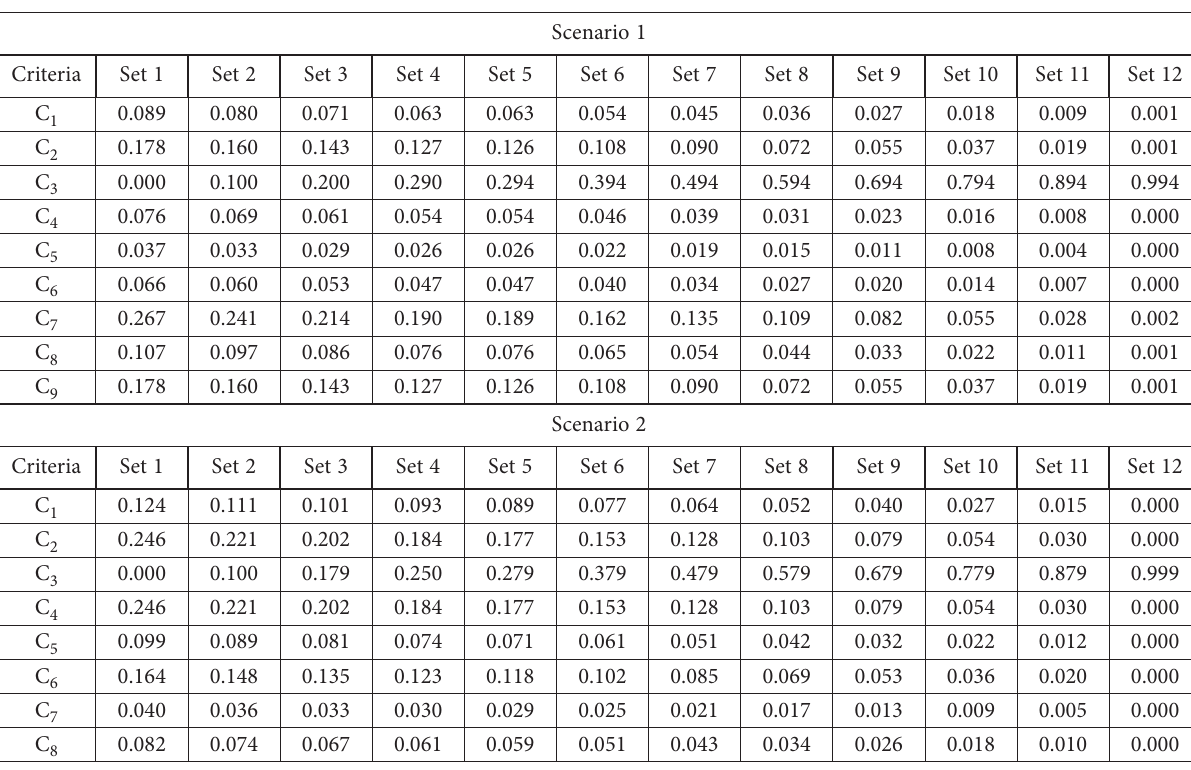
Table 16. The new criteria weights for Scenario 1 and Scenario 2